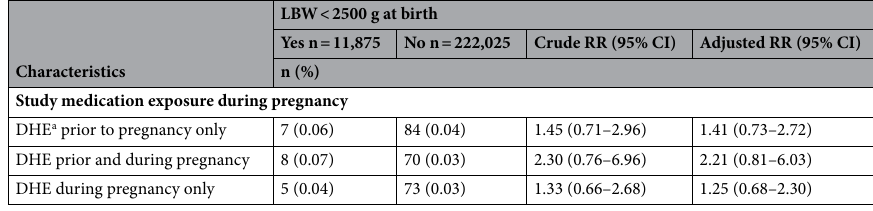
Table 8. Association between DHE exposure before or during pregnancy and the risk of LBW by categories of DHE exposure. Adjusted for all variables included in Table 3. a Dihydroergotamine.